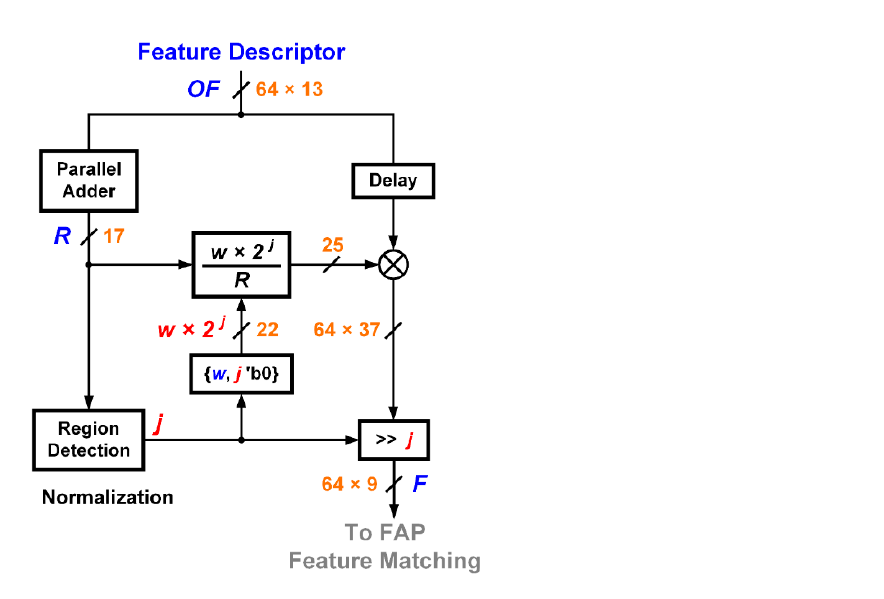
Figure 9. Function blocks of the normalization of the feature descriptor.